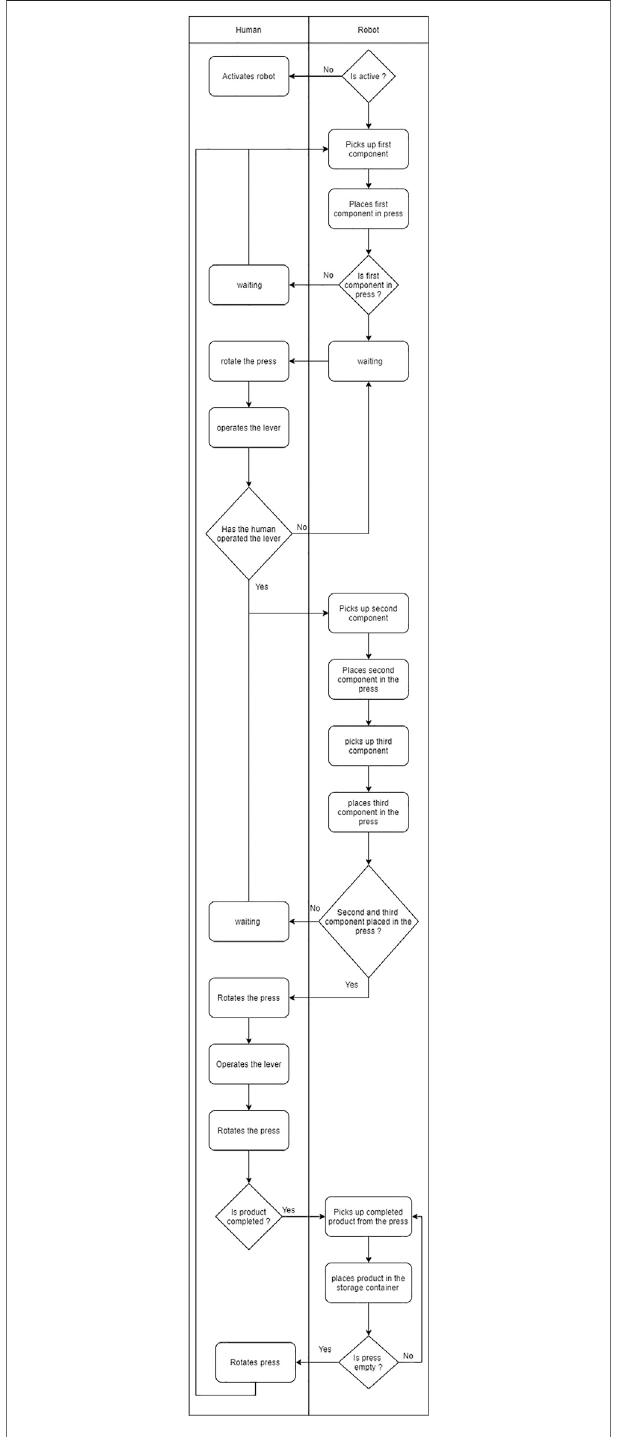
FIGURE 4 | The diagram illustrates the individual procedures required bythehumanparticipantandthevirtualrobotarmtoexecutethesharedtask.